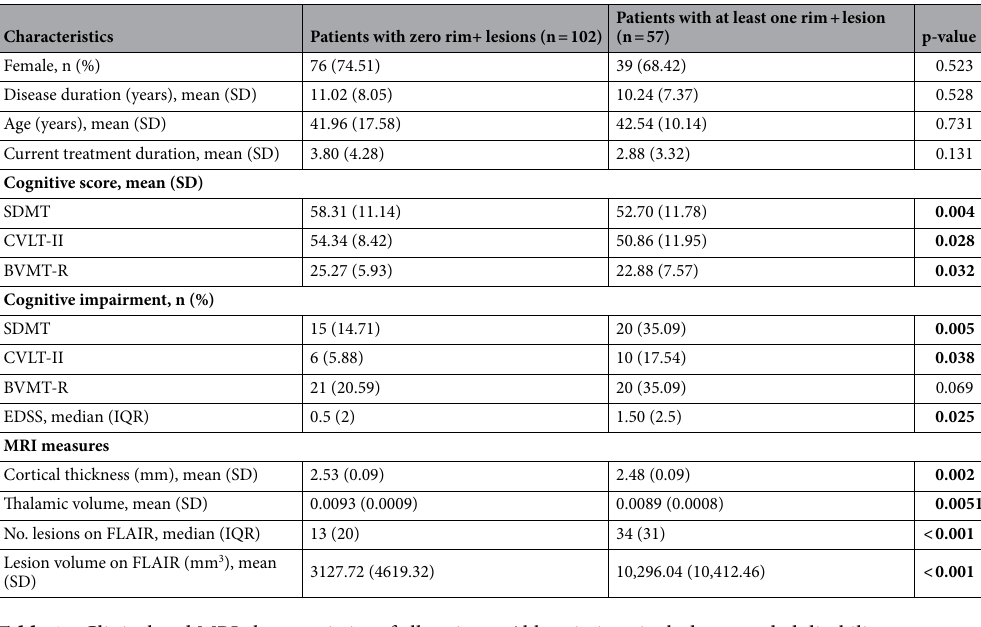
Table 1. Clinical and MRI characteristics of all patients. Abbreviations include expanded disability status score (EDSS), symbol digit modality test (SDMT), California verbal learning test-II (CVLT-II), and brief